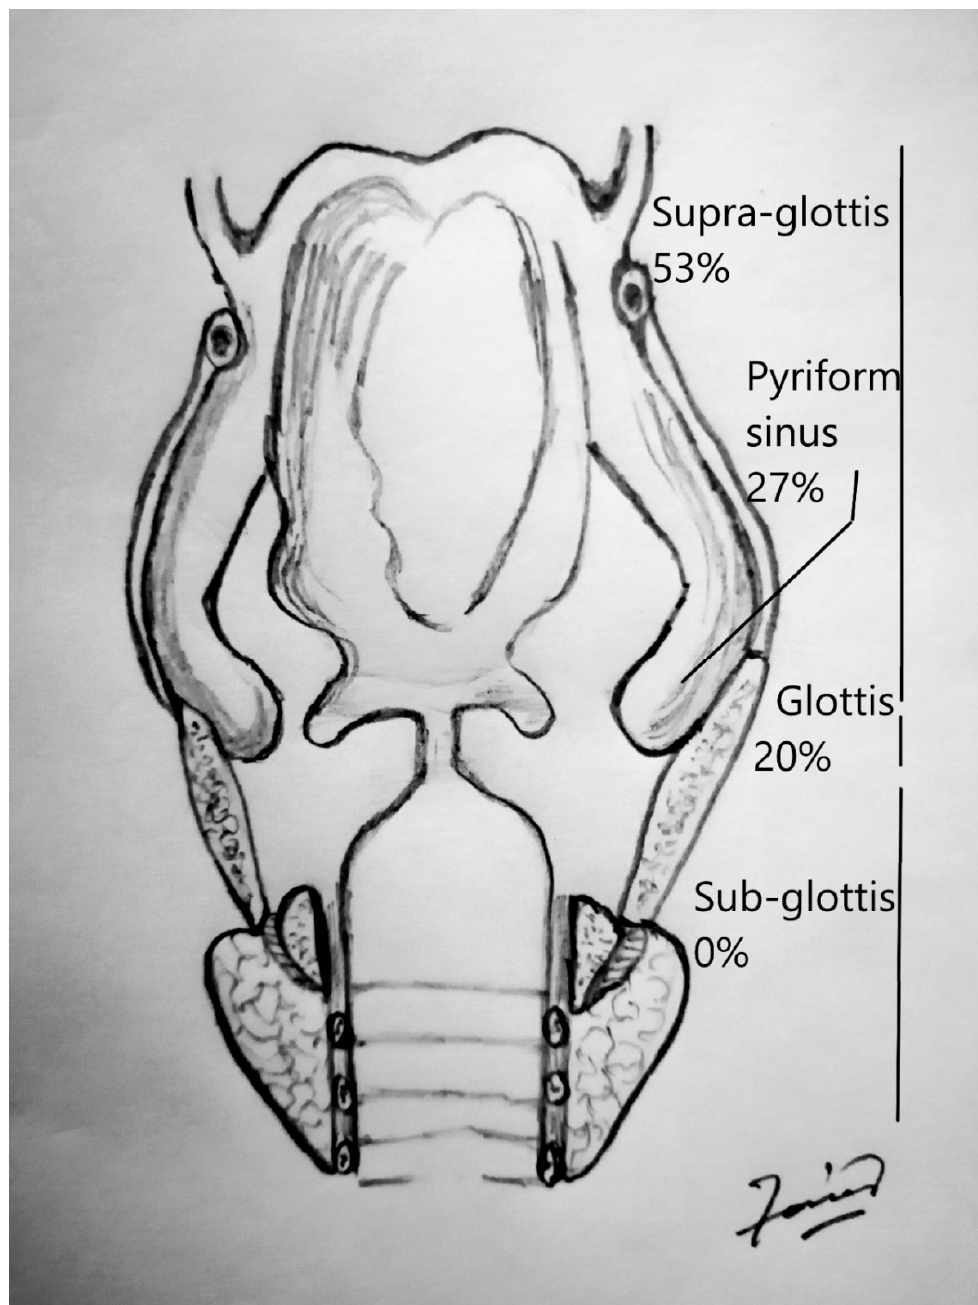
Figure 1. Distribution of lymphoepithelial carcinoma (LEC) in laryngeal and hypopharyngeal sub-sites.